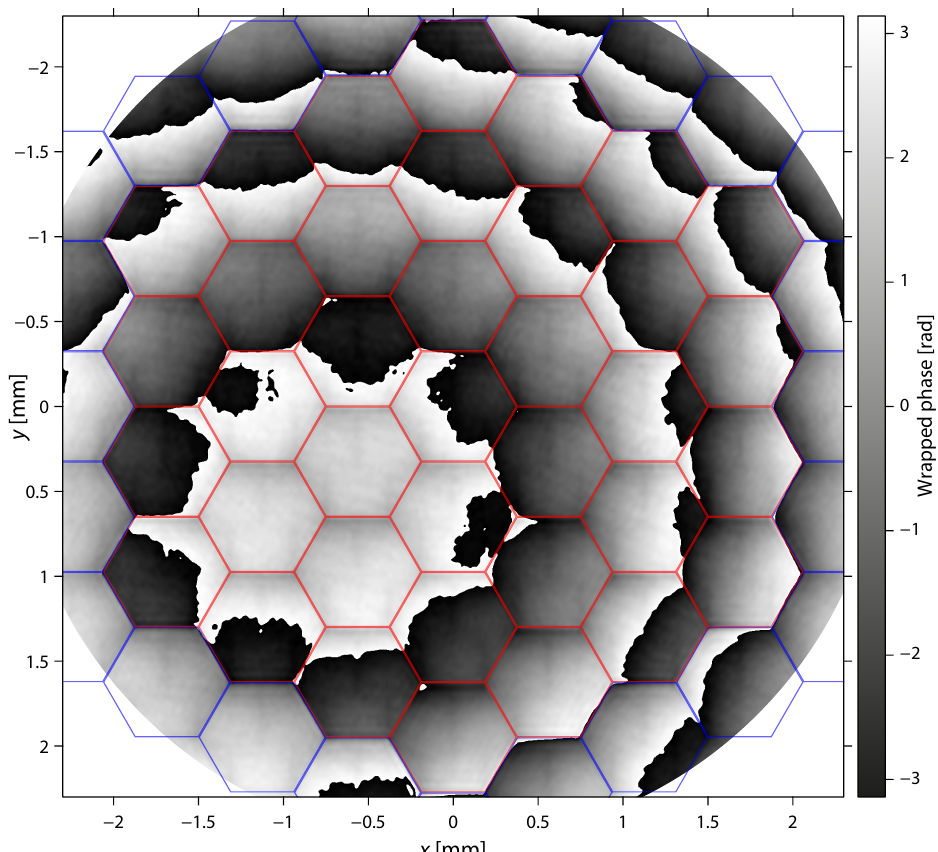
Figure 4. Wrapped phase map φ ( x , y ) . Red hexagons indicate the active segments, and blue hexagons indicate the inactive segments of the deformable